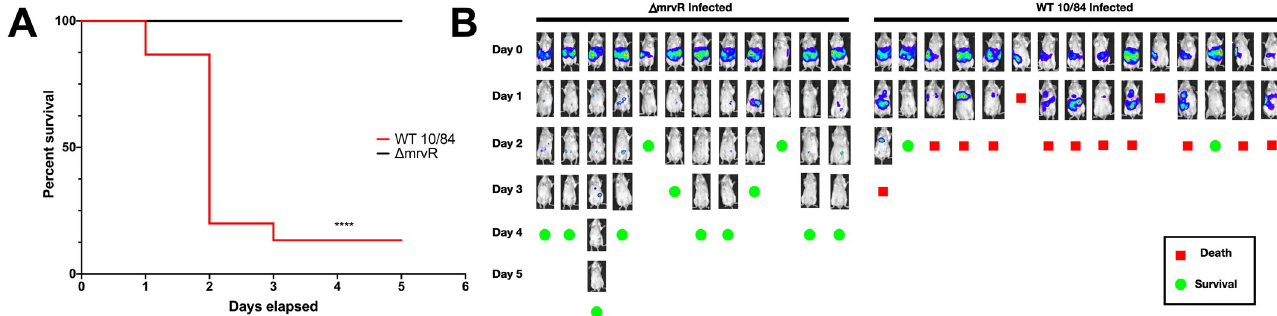
Fig 5. MrvR affects GBS invasiveness and lethality in a sepsis model. BALB/c mice were infected intraperitoneally with wild type (WT) 10/84 or Δ mrvR , both bearing a plasmid to allow in vivo tracking of a luciferase signal. There was a significant difference in outcome between the two strains ( A , ���� p < 0.001 Mantel- Cox test). Mice were imaged daily ( B ) until they either died (red boxes) or completely cleared the luciferase signal (green circles). Mice that cleared the luciferase signal were monitored for the following five days and remained